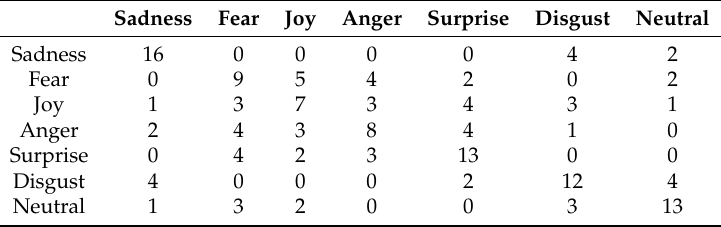
Table A16. P16 actor confusion matrix from the RekEmozio dataset in the second phase.